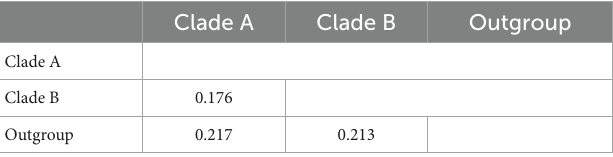
TABLE 2 The genetic distance for the Cyclommatus stag beetles (Kimura 2-parameter). Clade A Clade B Outgroup Clade A Clade B 0.176 Outgroup 0.217